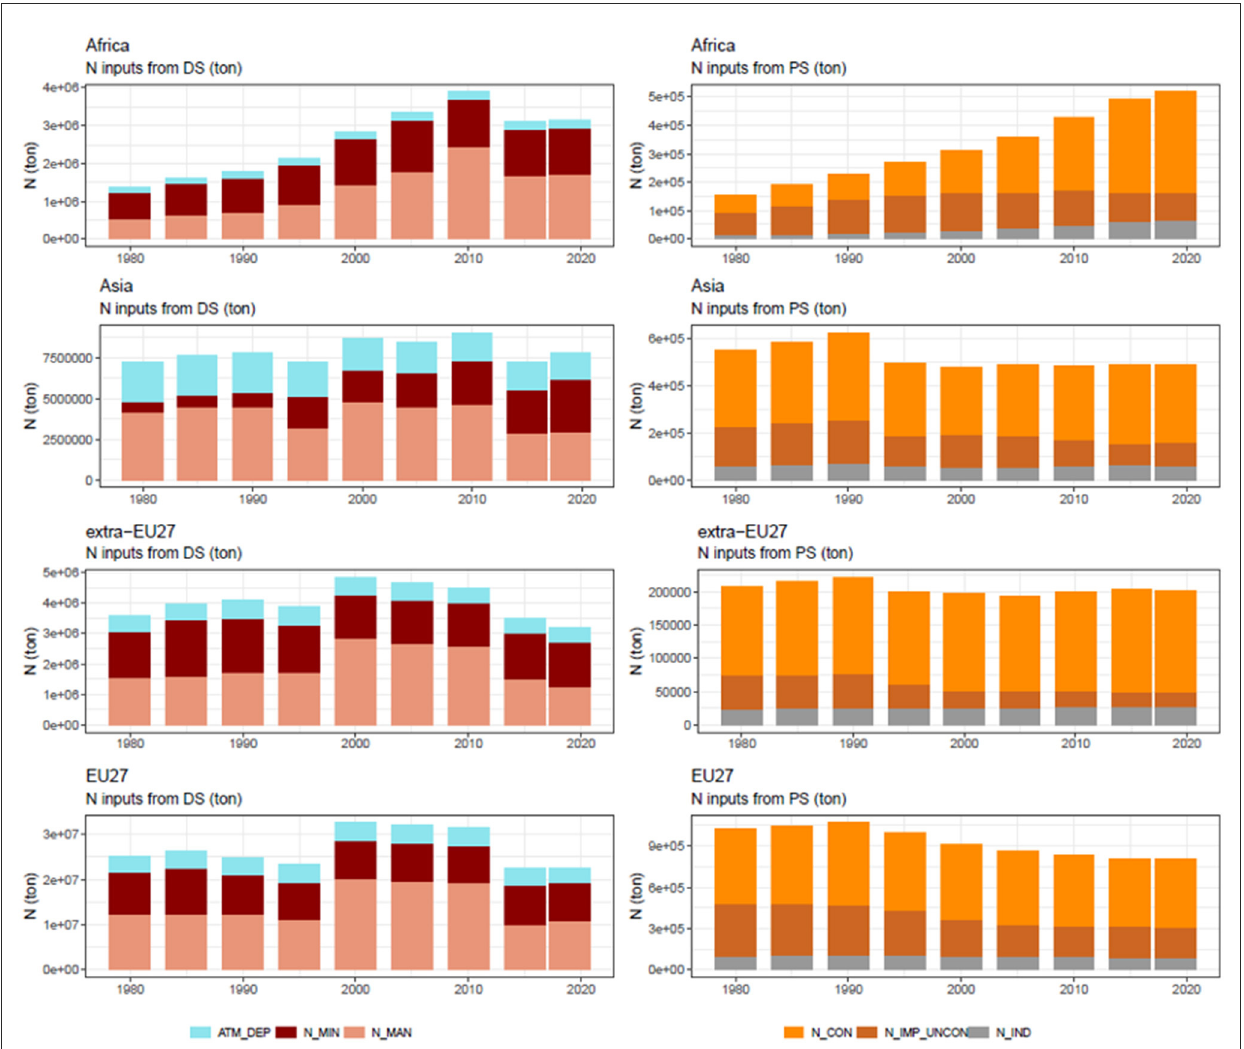
FIGURE7 Nitrogen inputs (ton) by selected continents in the study area. On the left , diffuse sources: ATM_DEP atmospheric deposition, N_MIN N mineral fertilizer, and N_MAN N manure; on the right , point sources: N_CON N emissions collected from sewerage systems; N_IMP_UNCON N emissions from other systems that are disconnected from sewerage systems; and N_IND N contribution from industrial